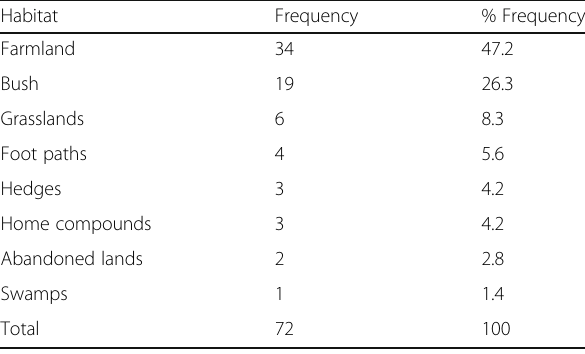
Figures are inclusive of each